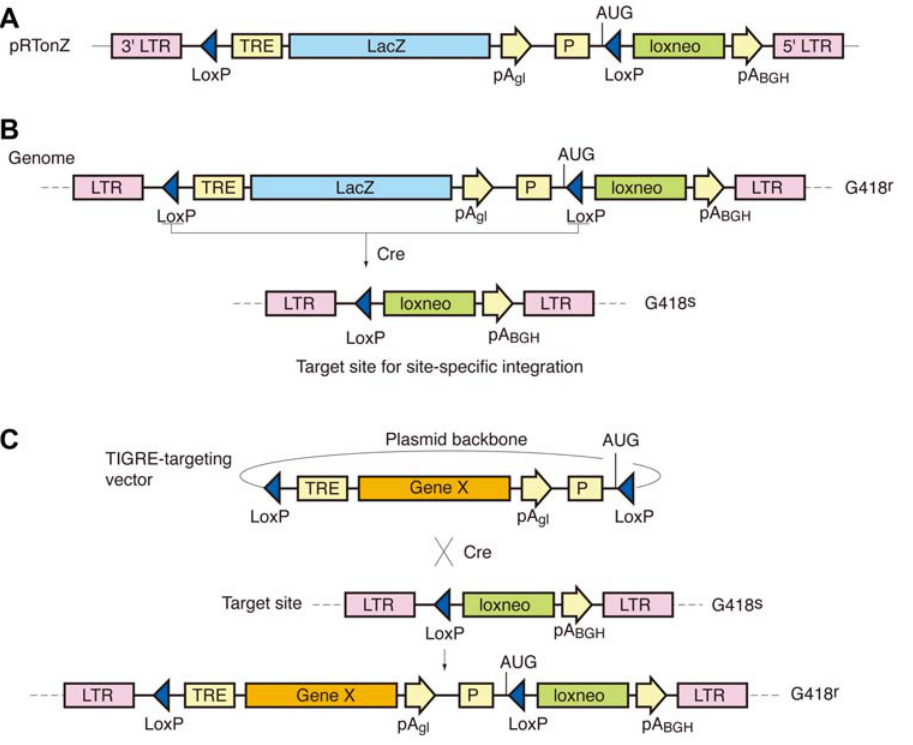
Figure 2. Retroviral vector used to search for tightly regulated loci and strategy to introduce a new gene into these predetermined loci. (A) Structure of the pRTonZ retroviral vector. To prevent effects of viral enhancer on the TRE promoter, the enhancer sequence was deleted in the 3 9 long terminal repeat (LTR). Subsequent transduction into target cells is expected to lead to enhancer deletion in both LTRs. The insert was cloned in the opposite orientation of the LTRs, so that the polyA addition signals would not decrease the viral titer. (B) Excision of the lacZ reporter gene from TIGRE loci. LoxP-flanked sequences within the retroviral vector are removed by transient expression of Cre recombinase in ES cells, leaving a single copy of loxP site in the genome. ES cells become G418-sensitive since the loxneo gene loses its promoter and initiating AUG. (C) Introduction of a new gene into the TIGRE locus. The G418-sensitive ES cells selected in (B) are cotransfected with the TIGRE-targeting vector carrying a new gene (gene X) and the Cre expression vector. Proper Cre-mediated recombination between the TIGRE-targeting vector, containing the new gene, and the TIGRE site introduces the new gene into the TIGRE locus and converts the G418 sensitive ES cells into G418 resistant (the expected recombinant leads to neo expression by placing the PGK promoter and initiating AUG upstream of the loxneo gene). Symbols are: pA gl , rabbit b -globin gene polyA addition signal; P, mouse phosphoglycerate kinase-1 gene promoter; AUG, initiating AUG of neomycin phosphotransferase gene; loxneo, neomycin phosphotransferase gene having loxP sequence in-frame to initiating AUG; pA BGH , bovine growth hormone gene polyA addition signal; G418 r , G418 resistant; G418 s , G418 sensitive.